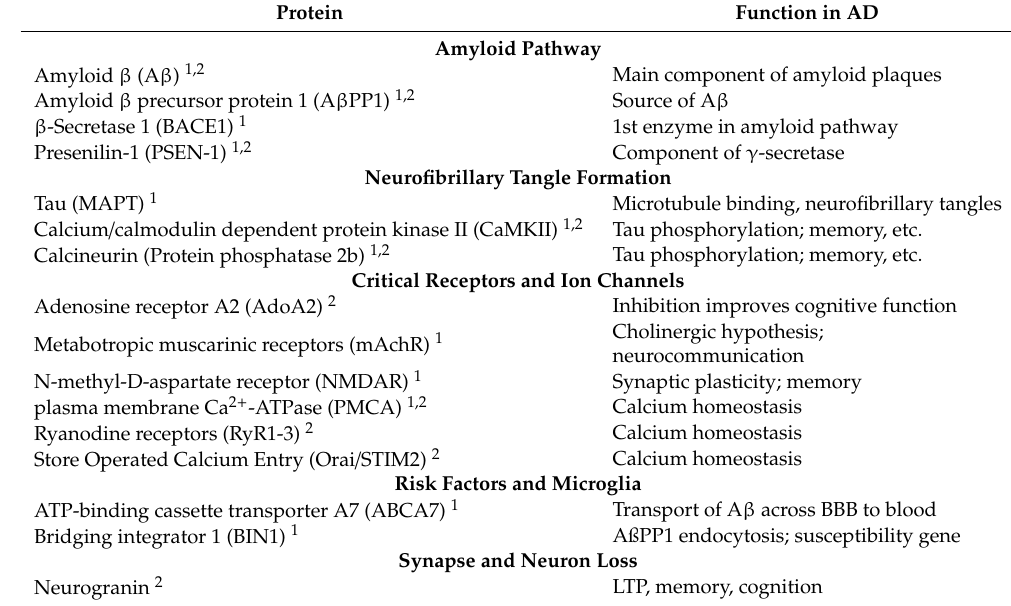
Table 1. Verified calmodulin binding proteins directly linked to Alzheimer’s